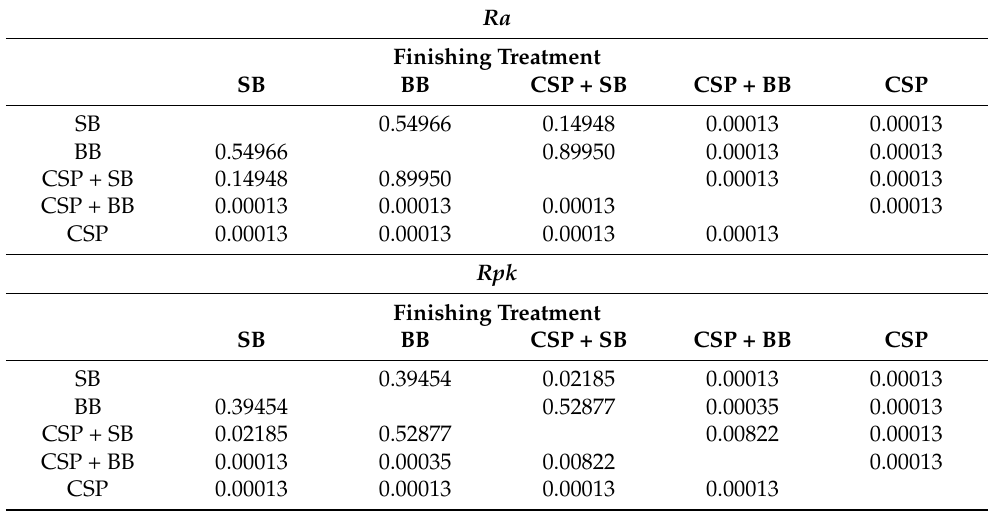
Table 3. Comparative analysis of the significance of differences (post-hoc/Tukey’s test) between the mean values of the roughness parameter Ra and Rpk after treatment with various methods. The level of probability for which there are statistically significant differences is marked in red.